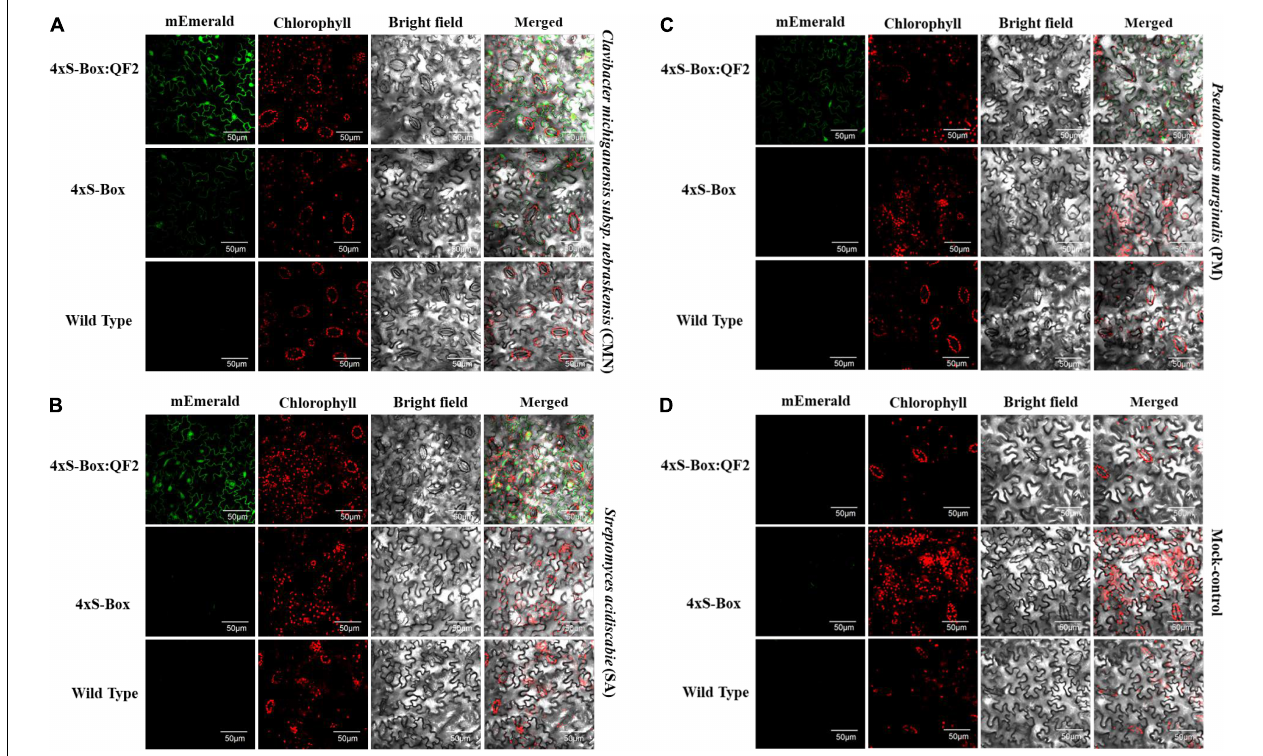
FIGURE 5 | Confocal micrographs of the pathogen phytosensors. Confocal micrographs showing expression of mEmerald fluorescent protein in leaf cells of transgenic phytosensor 4xS-Box:QF2 (with Q-system), 4xS-Box (without Q-system), and wild type plants inoculated with bacterial pathogens (A) Clavibacter michiganensis subsp. nebraskensis (CMN), (B) Streptomyces acidiscabie (SA), (C) Pseudomonas marginalis (PM), and (D) 10 mM MgCl 2 (mock-control). Plants were infiltrated with a bacterial inoculum of OD 600 = 0.3, corresponding to colony forming units (cfu) of 3 × 10 8 cfu/ml CMN, 3 × 10 8 cfu/ml SA, and 1 × 10 8 cfu/ml PM. Images were recorded at 72 h post inoculation. In total three independent experiments with four biological replicate plants ( n = 4) per experiment was performed. Images representative of one independent line per construct. The intensity of mEmerald was increased in the cells of phytosensors with the Q-system. Scale bar: 50 µ m, magnification: 60 ×